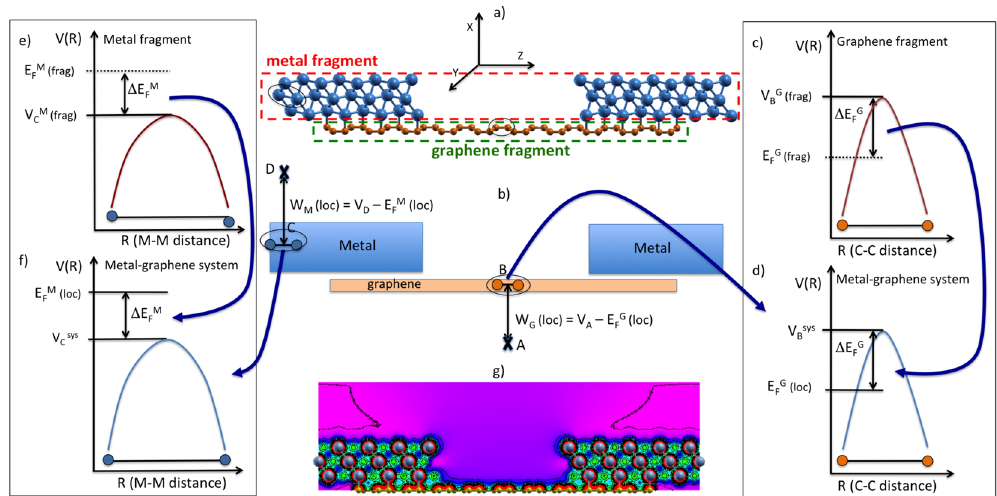
Figure 3. Analysis of the electrostatic potential in the case of the Ni medium structure. ( a ) Atomistic and ( b ) schematic representation of graphene-metal contact. The electrostatic potential ( V ( R )) analysis is also shown. ( c ) 1-D plot of V ( R ) between nearest neighbors carbon atoms of the graphene fragment; ( e ) 1-D plot of V ( R ) between nearest neighbors metal atoms of the metal fragment. From ( c,e ), the difference between the V ( R ) in the middle of the ( c ) C - C or ( e ) M - M bond and the Fermi energies of the fragments is extracted as ∆ E FG and ∆ E FM , respectively. ( d,f ) 1-D plot of V ( R ) between nearest neighbors ( d ) carbon atoms or ( f ) metal atoms of the component system, respectively. Using the ∆ E FG , ∆ E FM values from ( c,e ), the local Dirac point E D (loc) and the local Fermi energy in the metal E F (loc) are determined. Hence, the local Fermi energies are substracted to the appropriate vacuum levels to obtain in ( b ) the local Work Functions: W G (loc) = V A − E D (loc) and W M (loc) = V D − E F (loc) of graphene and metal components, respectively. ( g ) 2D-plot of V ( R ) on a ( x , z ) plane containing both metal and graphene